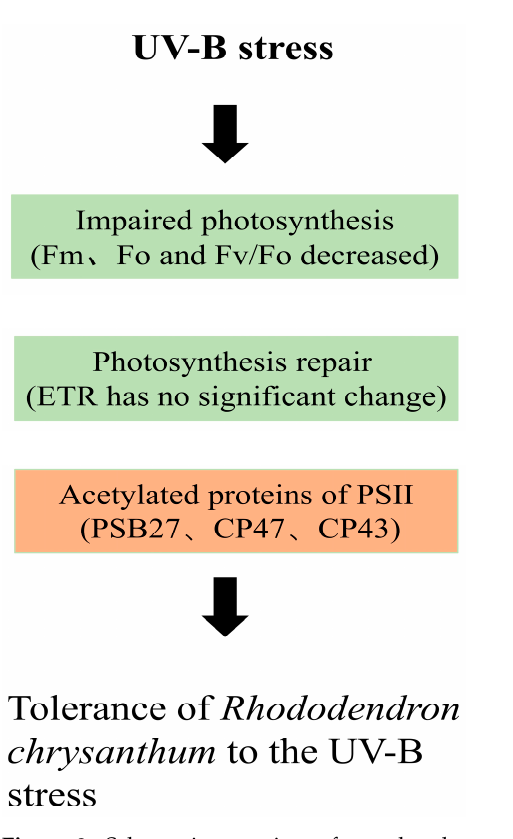
Figure 8. Schematic overview of acetylated proteomic strategy against UV-B stress in Rhododendron chrysanthum . Photosynthetic adaptation (green box) and PSII acetylated protein (yellow box) are shown.